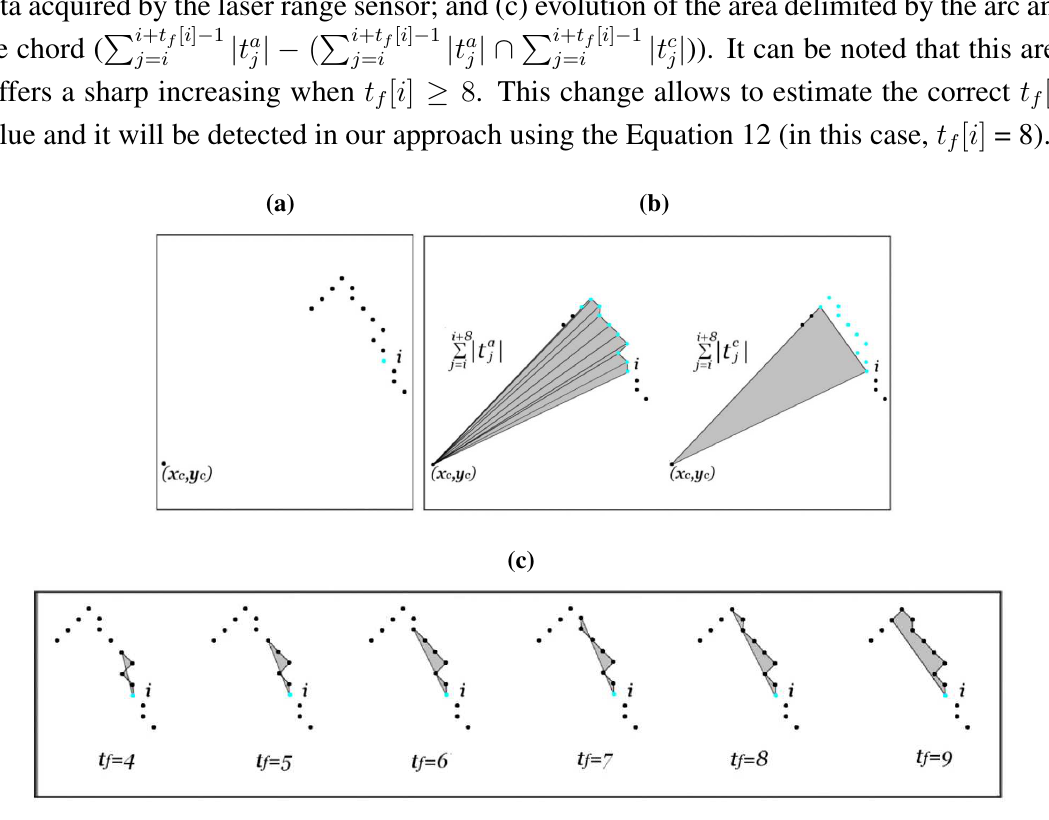
Figure 8. Calculation of the maximum length of contour presenting no significant disconti- nuity on the right side of range reading i ( t [ i ] ): (a) Part of the laser scan and point i ; (b) scan f data acquired by the laser range sensor; and (c) evolution of the area delimited by the arc